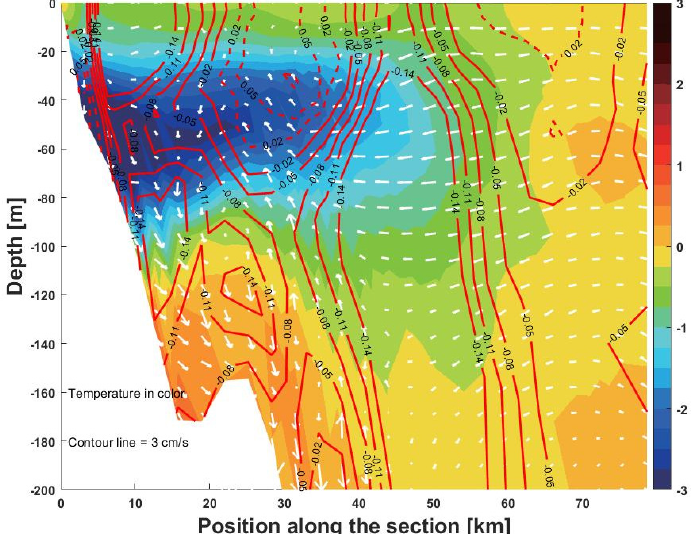
Figure 11. Composited shore-normal transect of tidal residuals, including temperature (in color shading, °C) and cross-shelf velocity (solid contours denote southward velocities, whereas dashed contours are northward currents). White arrows denote current directions along the transect.